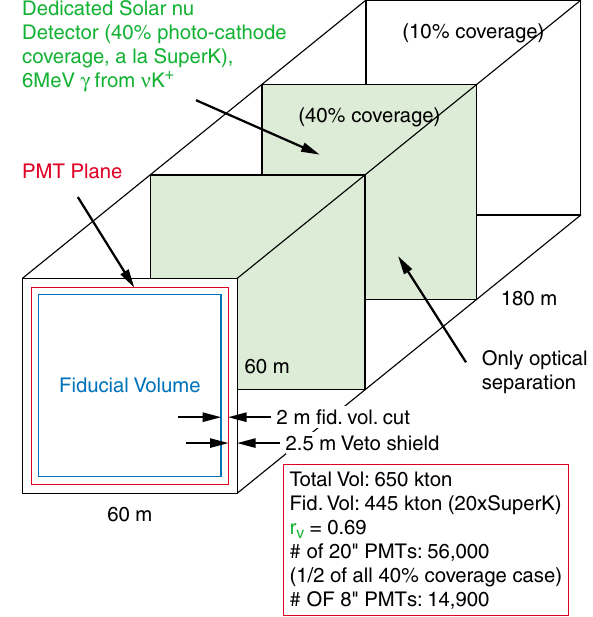
FIG. 29. (Color) A possible 50 kt steel-scintillator-PDT detec- tor at WIPP.